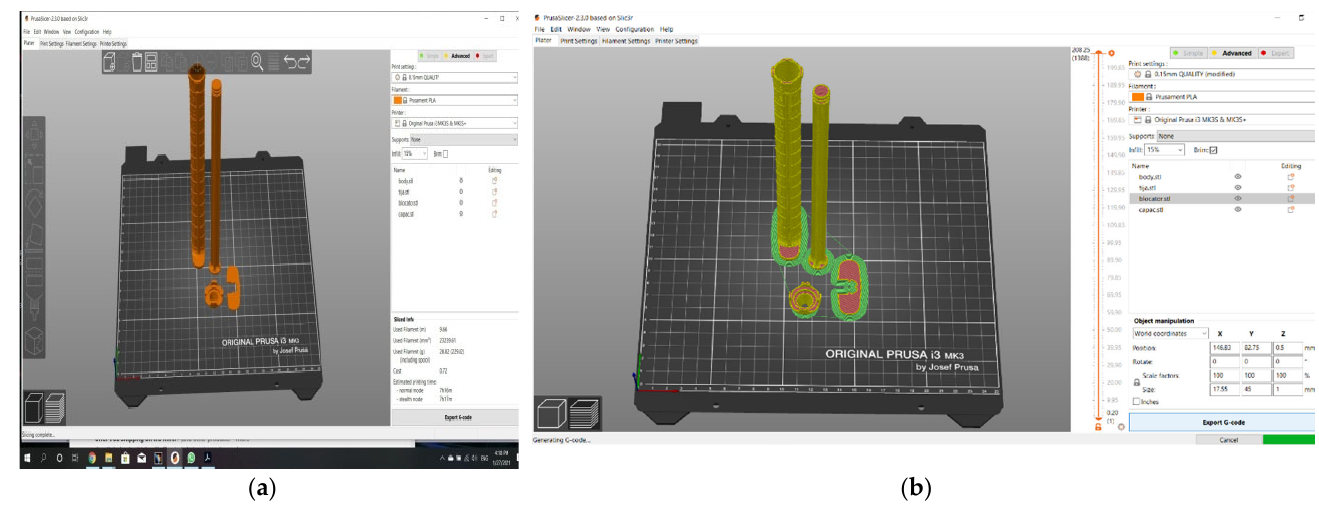
Figure 2. The modelling and making process of the dispenser using the Prusa I3 MK3S+ Printer: ( a ) stage 1 and ( b ) stage 2.